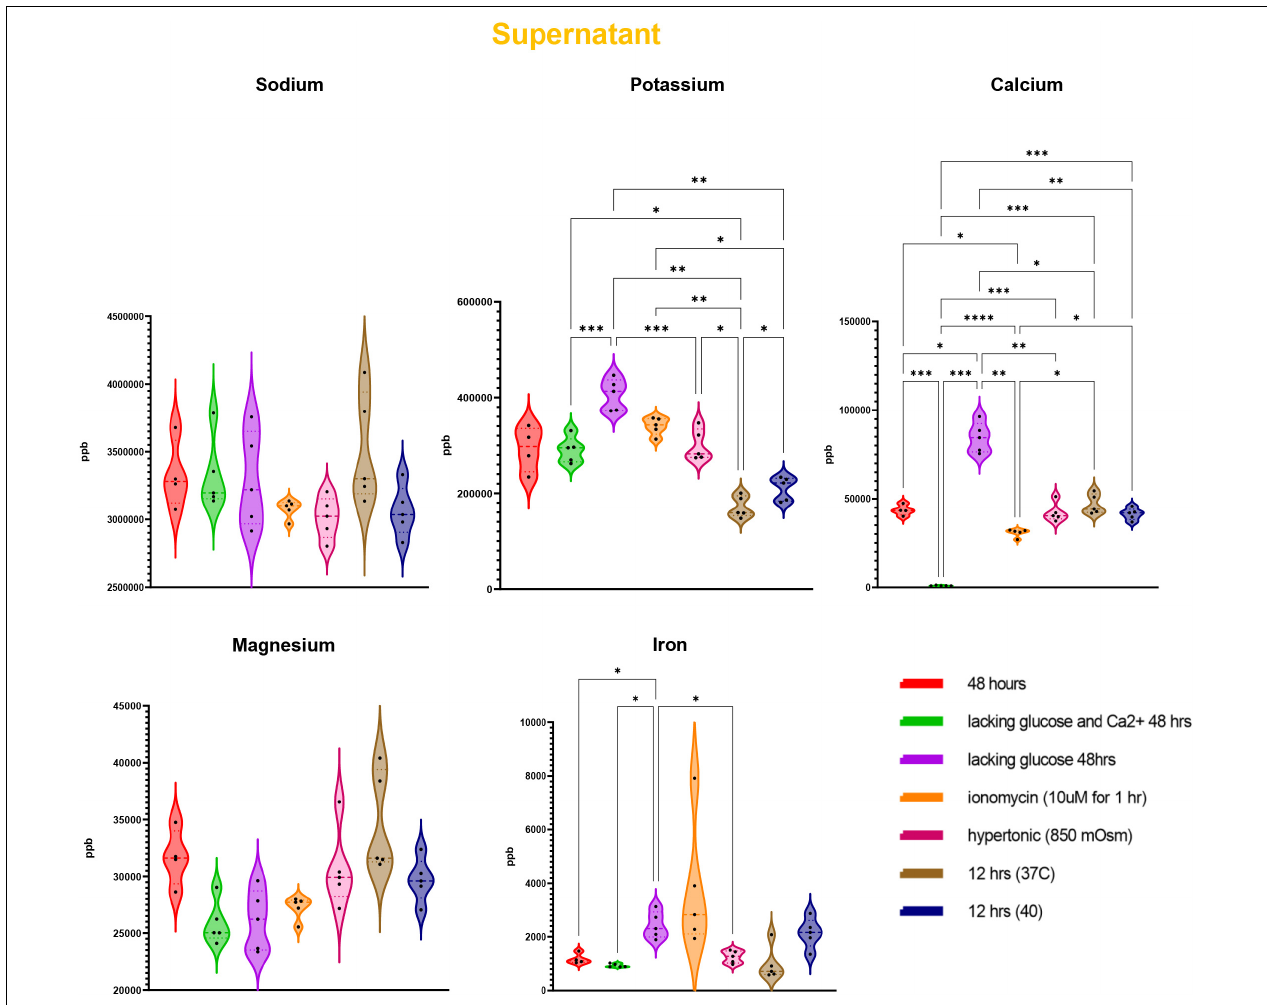
FIGURE 2 | Measurements of trace elements in supernatants exposed to starvation (glucose or glucose and calcium), ionic (ionomycin or hypertonic saline), or heat stress (40 vs. 37 ◦ C). Significance was determine via ANOVA with Tukey’s multiple comparison test ( ∗ p < 0.05; ∗∗ p < 0.01; ∗∗∗ p < 0.001; ∗∗∗∗ p <